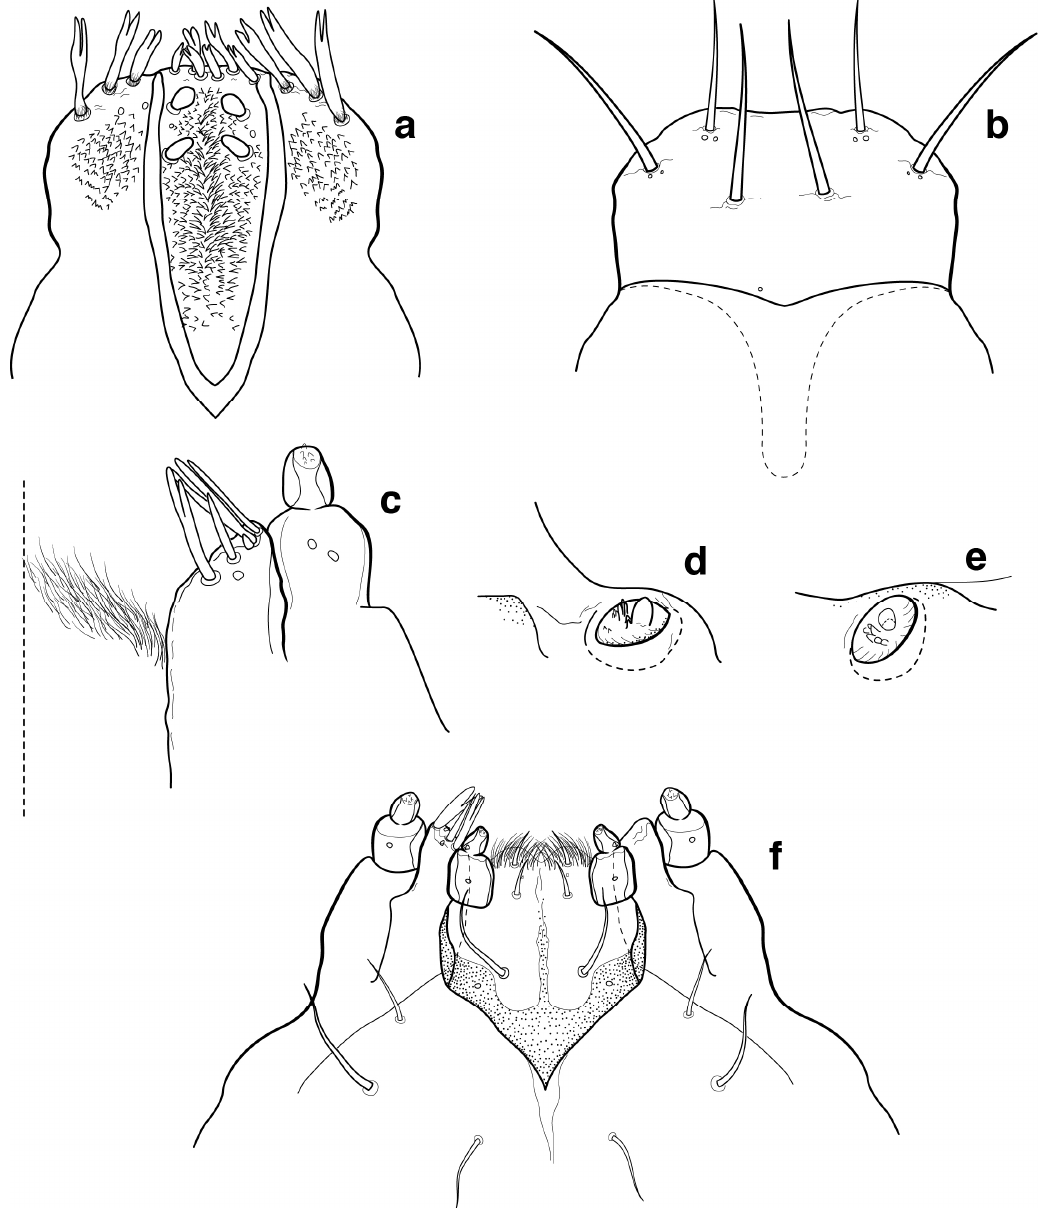
Figure 64. Eugnoristus braueri mouthparts: ( a ) epipharynx; ( b ) clypeus (incomplete) and labrum; ( c ) hypopharynx, mala, and maxillary palp, dorsal view; ( d ) antenna, oblique-lateral view; ( e ) antenna, antero-lateral view; and ( f ) labio-maxillary complex, ventral view.